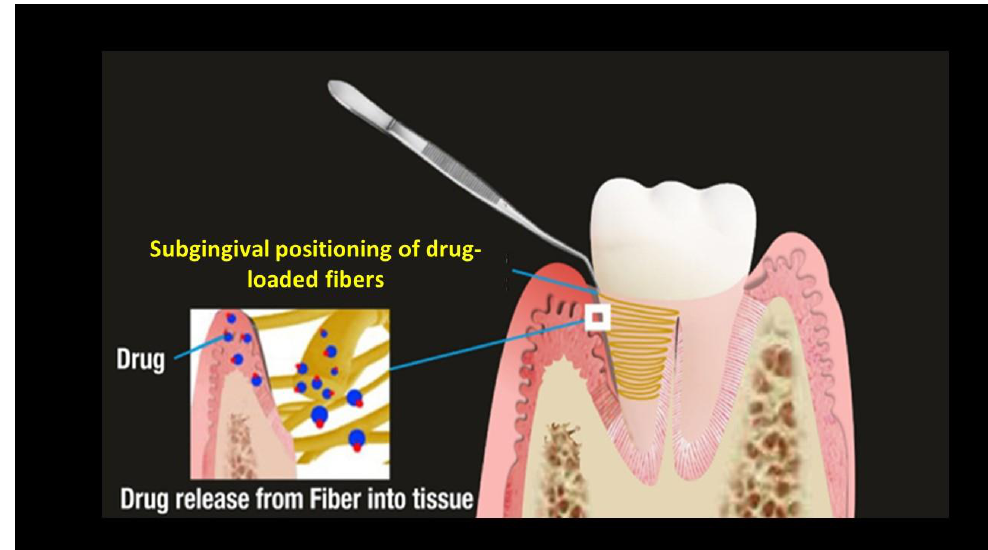
Figure 2. Fibers and their placement. Reproduced with the permission from Rajeshwari et al.